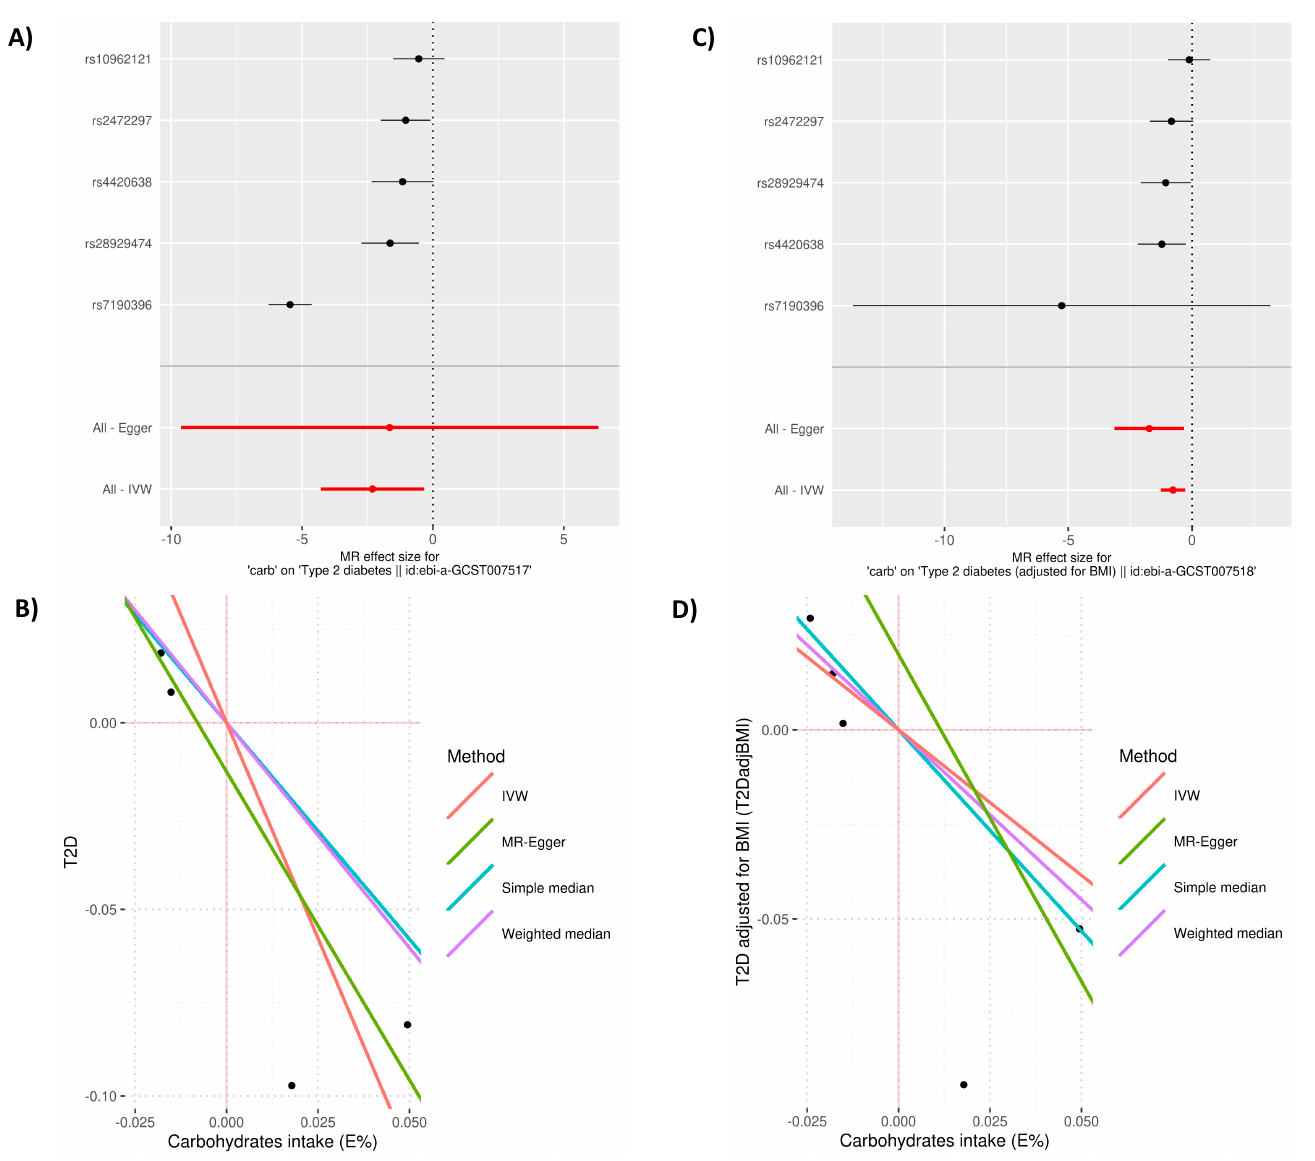
Figure 4. Forest plot of 5-SNP instrument and scatter plot of SNP effects on exposures versus outcomes using different MR methods. For the forest plot, effect size and 95% confidence intervals (standard deviation (SD) change) of the impact of carbohydrates intake SNPs. ( A , B ) correspond to carbohydrates (E%) → T2D; ( C , D ) correspond to carbohydrates (E%) → T2D adjusted for BMI (T2DadjBMI).